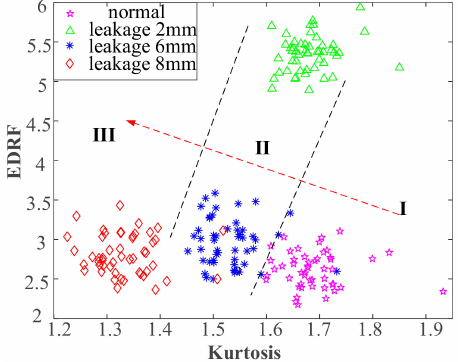
Figure 15. Quantitative diagnoser of RC valve